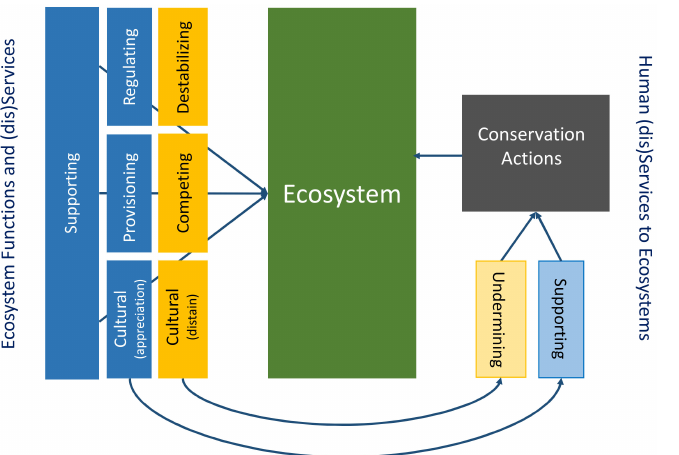
Figure 1. Supporting, provisioning and regulating ecosystem services and associated cultural ecosystem services as proposed by the Millennium Ecosystem Assessment (blue symbols). Note that provisioning and regulating ecosystem services have potential corresponding disservices for human societies (orange symbols). Nature can also provide cultural ecosystem disservices (e.g., the cultural disapproval of some species due to an unappealing appearance or behaviour). Human societies also affect the health, welfare and status of species through services to ecosystems that may be positive (e.g., conservation) or negative (e.g., exploitation). The nature of these ‘services to ecosystems’ is determined by supporting (dis)services that can be pastoral (light blue symbol) or exploitative (light yellow symbol). Note that cultural ecosystem (dis)services are directly related to supporting (dis)services from human societies to